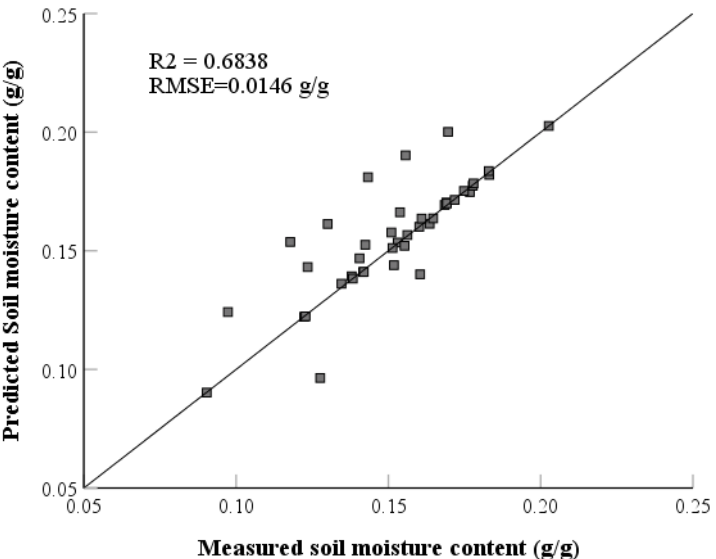
Figure 9. Comparison of Erf-BP neural-network modeling with various of hidden-layer nodes.